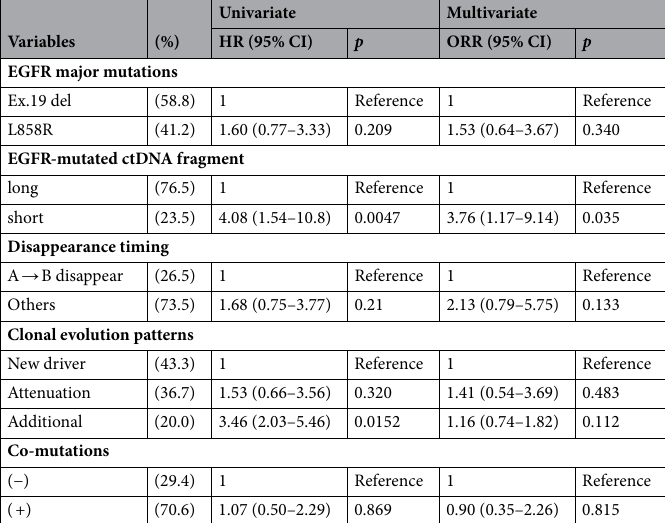
Table 2. Analysis of clinical and ctDNA risk factors for PFS of